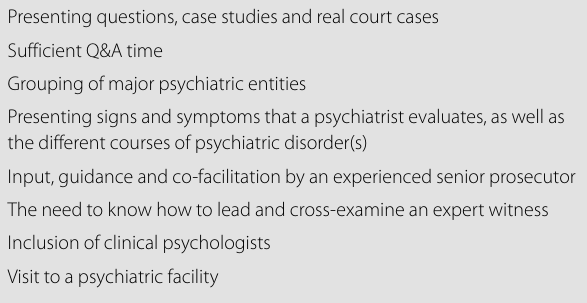
Table V. Important issues considered to improve workshop facilitation Presenting questions, case studies and real court